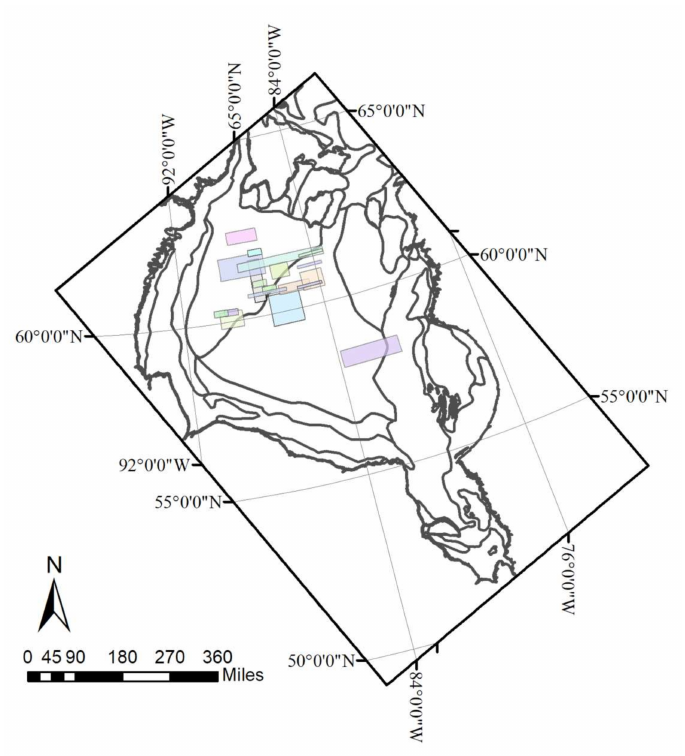
Figure 6. Specific regions selected according to the sampling principles. Note : The color is to show the location of different regions more clearly and has nothing to do with the ice